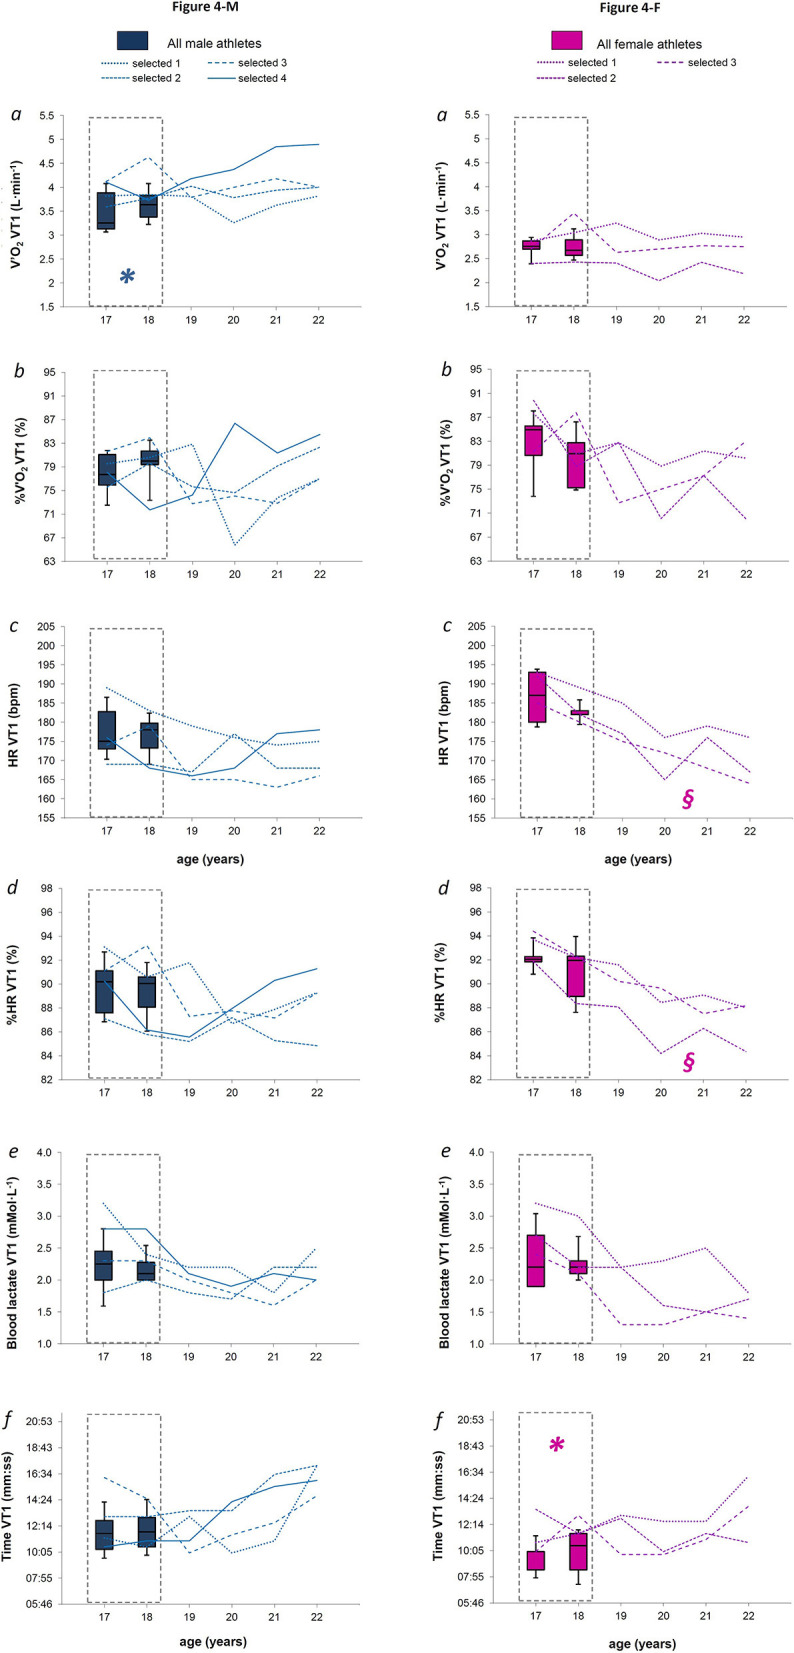
Figures 4-M and 4-F. For males and females (Figures 4-M and 4-F, respectively), the box plot represents medians, 9, 25, 75, and 90th percentiles of the values measured at the first ventilator threshold (VT1) for absolute oxygen consumption (panel a), relative oxygen consumption (panel b), absolute heart rate (panel c), relative heart rate (panel d), blood lactate concentration (panel e), and time of first threshold occurrence (panel f) measured over the late teenage period (data in dotted-lined boxes) in the entire group. In each panel, the line plots represent each selected athletes from 18 to 22 years of age. § indicates a most likely effect of age after the later teenage period, while * indicates possible parameters early identifying further athletes' selection, when all the criteria presented in the statistical analysis paragraph were satisfied.